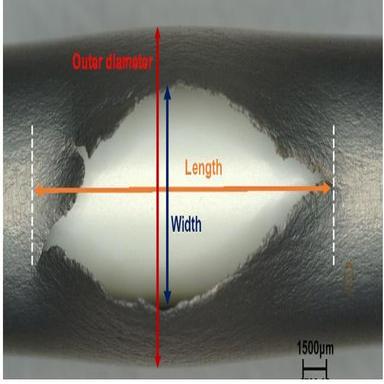
Burst parameters on a ruptured tube.